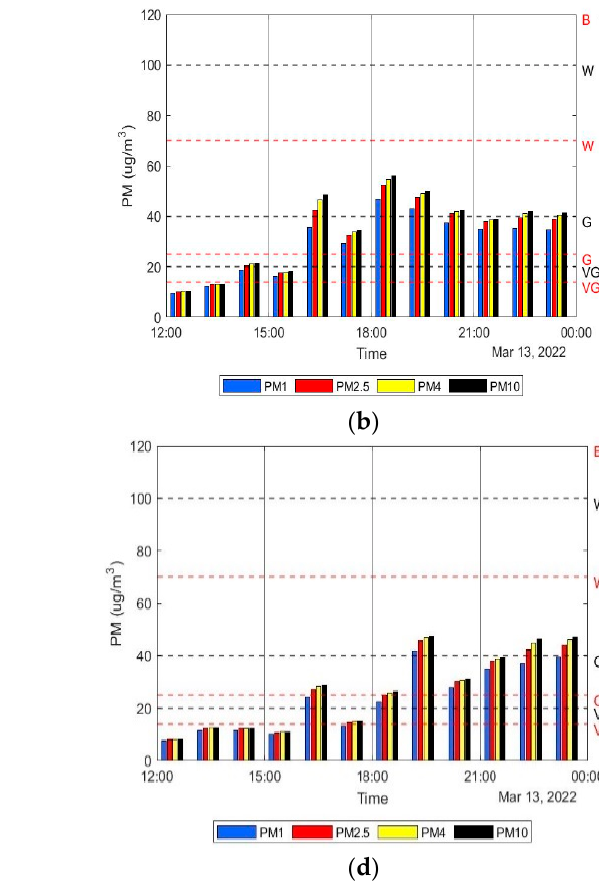
Table 9. Air Quality Index for the balcony measurement.